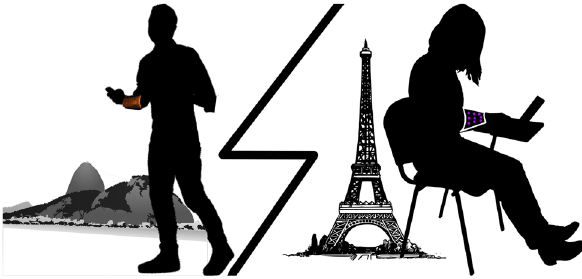
Figure 18: Motor activation converted from the touch information. The lighter color represents the motor that should be activated, in this case both motors from the second column.